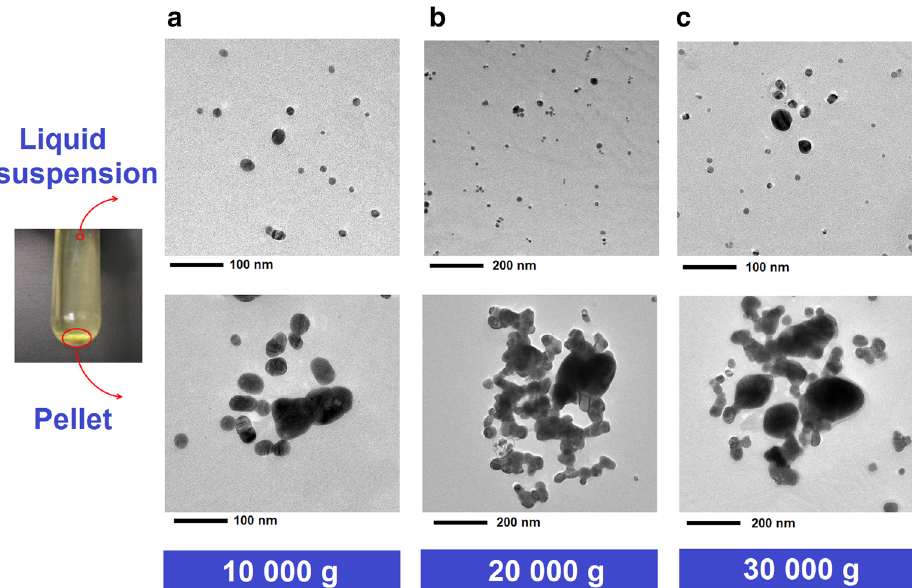
Figure 3. TEM images from the liquid suspension (supernatant) and pellet (sediment) obtained after purification of the raw AgNPs using different relative centrifugal